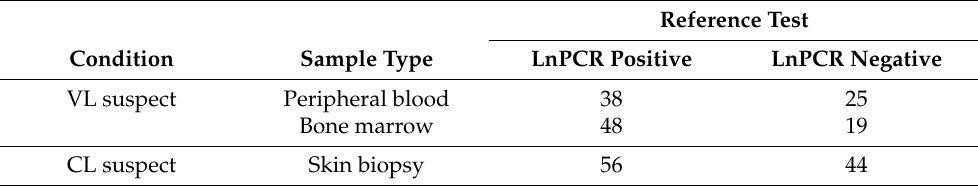
Table 1. Panel of samples used in this study, by clinical form (VL: visceral leishmaniasis. CL: cutaneous leishmaniasis) and result of the reference test ( Leishmania nested